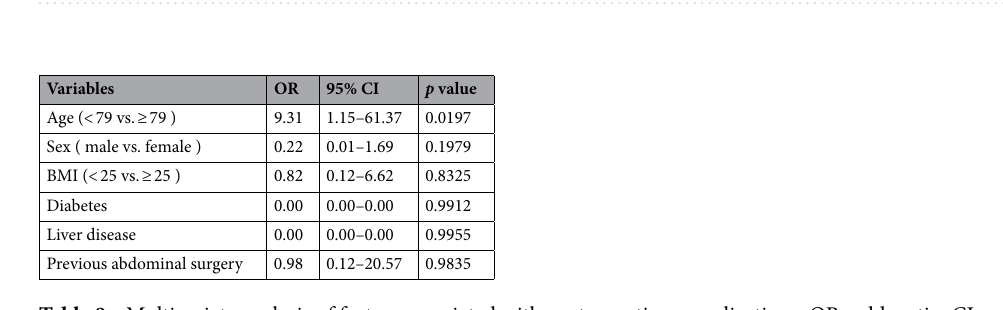
Table 8. Multivariate analysis of factors associated with postoperative complications. OR, odds ratio; CI, confidence interval.